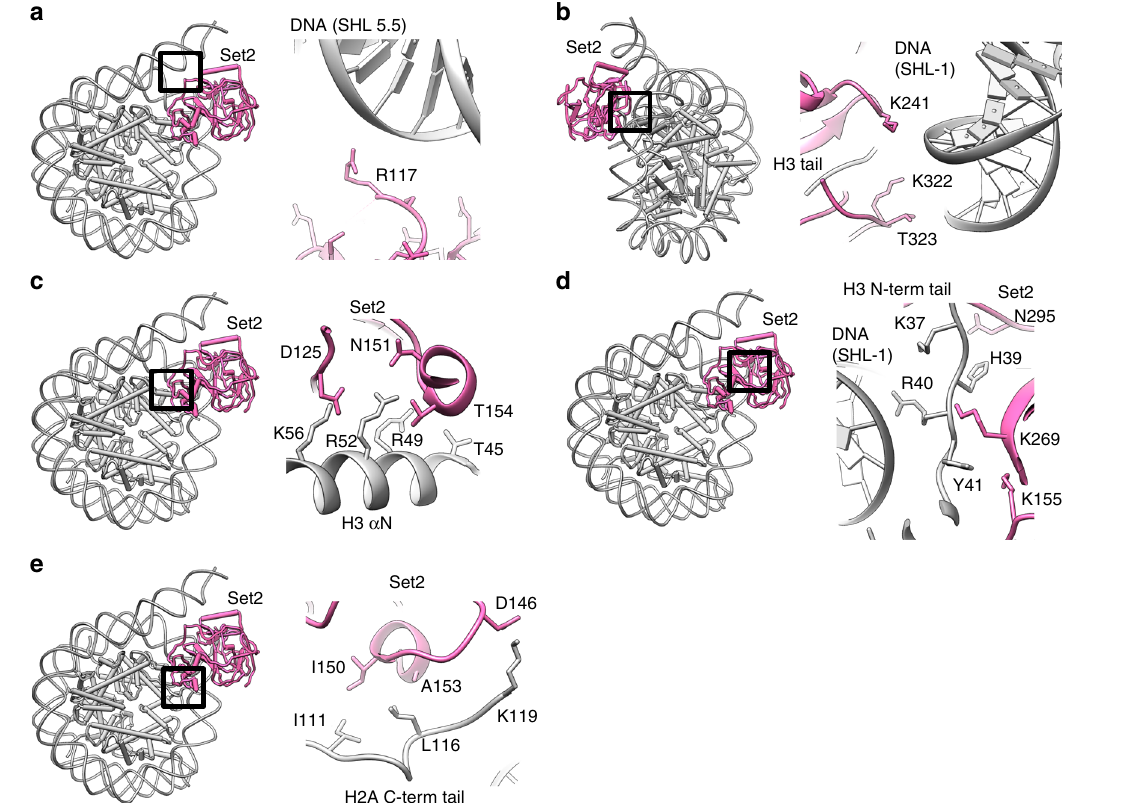
Fig. 2 Molecular interactions between Set2 and NCP. Global location of the depicted interaction between Set2 and the nucleosome is shown on the left and close up on the right. a Set2 residue R117 binds the backbone of the unwrapped DNA at SHL 5.5. b Set2 residues K241, K322, and T323 bind the backbone of the DNA at SHL-1. c Set2 binds H3 α N. Set2 residues D125, N151, and T154 bind the H3 K56, R52, R49 and T45. d The H3 tail makes extensive interactions with Set2 and the DNA. H3 R40 and K37 bind the DNA at SHL-1. H3 Y41 and H39 interact with Set2 residues K155, K268, and N295. Set2 residue K269 interacts with the main chain of H39. e Set2 binds the H2A C-terminal tail. Set2 D146 makes charged interaction with H2A K119. Set2 residues I150 and A153 make hydrophobic interactions with the H2A residues I111 and L116,